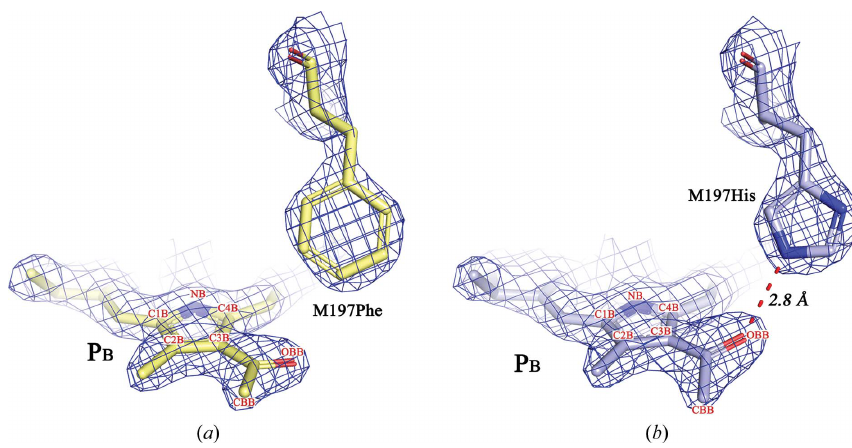
displacement of the O atom by 1.2 A˚ ; Fig. 3). Comparison of the structures obtained at room temperature shows a similar out-of-plane rotation of 33.4 (cid:4) , representing a total 32.8 (cid:4) anticlockwise rotation compared with that in the WT RC (0.6 (cid:4) out-of-plane anticlockwise rotation). The change in the orientation of this group in F(M197)H RC has previously been suggested in the work of Ivancich et al. (1998).